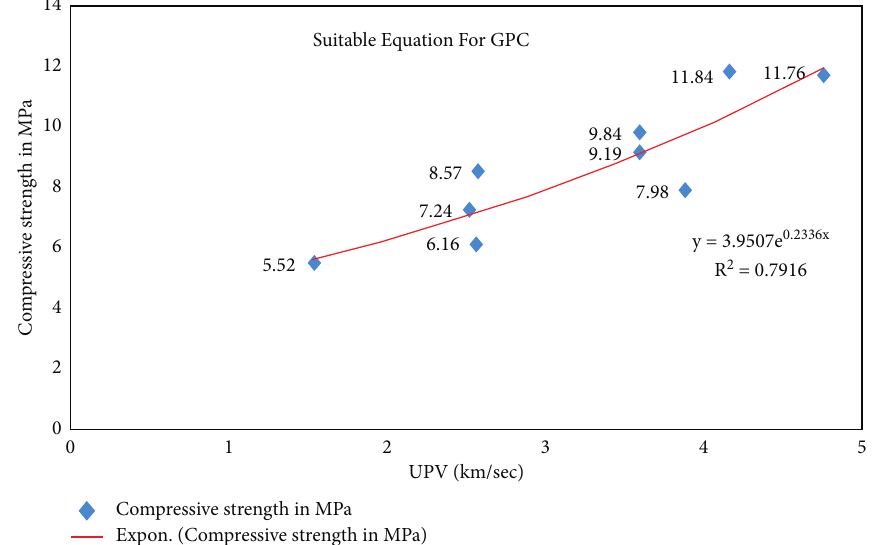
Figure 12: Equation obtained for